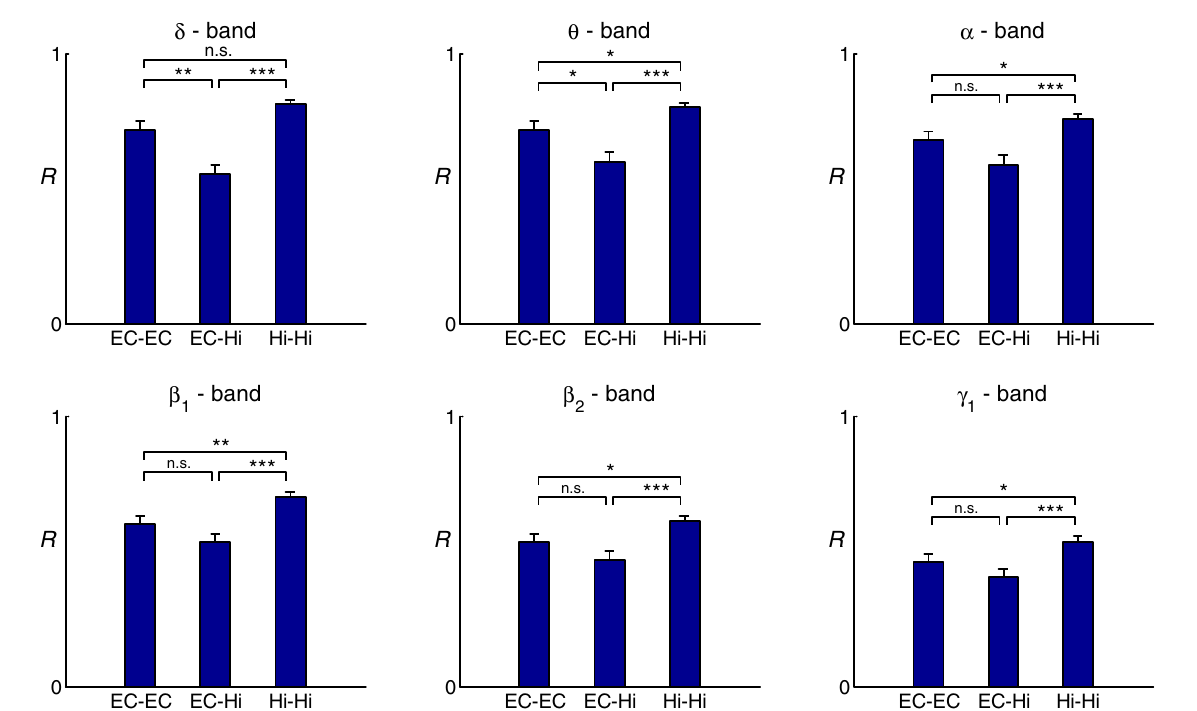
Figure 3. Group statistics for 22 patients. Comparison of intra- and inter-regional synchrony within and between the entorhinal cortex and hippocampus for different frequency bands. Bars depict mean levels of synchrony across patients within the entorhinal cortex (EC–EC), between entorhinal cortex and hippocam- pus (EC–Hi), and within the hippocampus (Hi–Hi), respectively, with error bars denoting the standard error. n.s. = not signifi cant, * = p < 0.05, ** = p < 0.01, *** = p < 0.001 (two-sided Wilcoxon test; uncorrected p-values). Note that a statistically signifi cant inter-regional gap in synchrony as defi ned in the methods section is observed only for the delta and theta